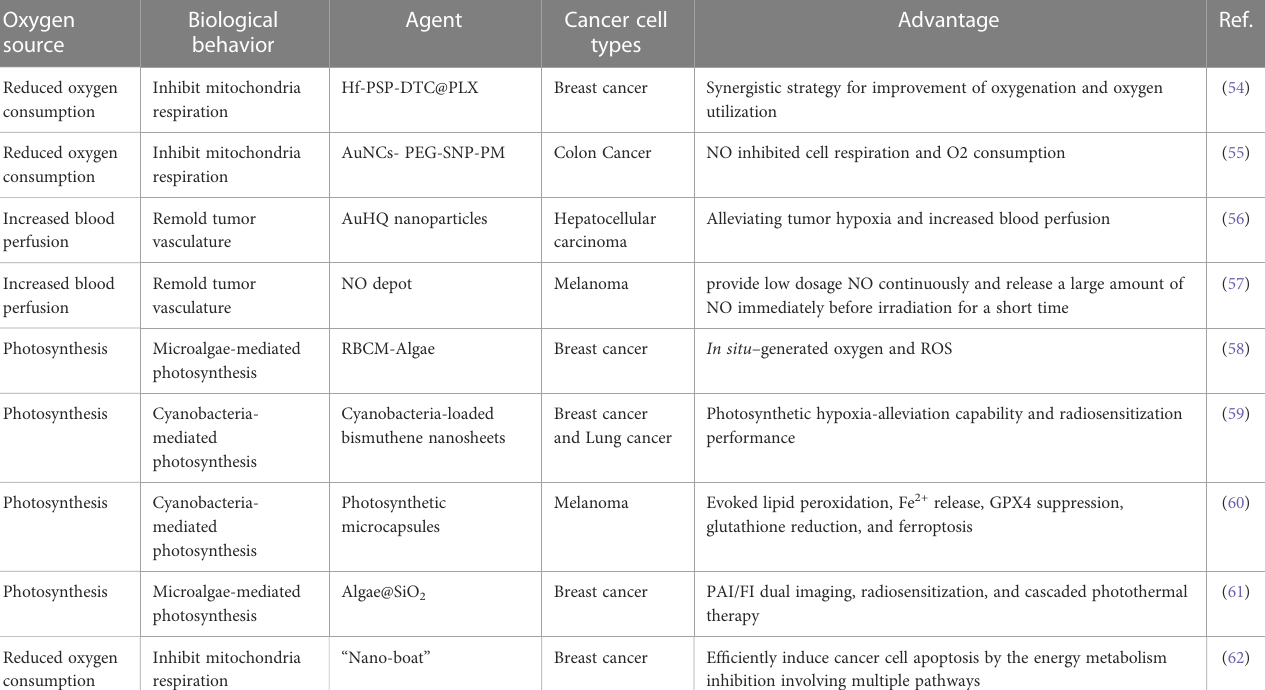
TABLE 3 Biological strategies-based oxygen